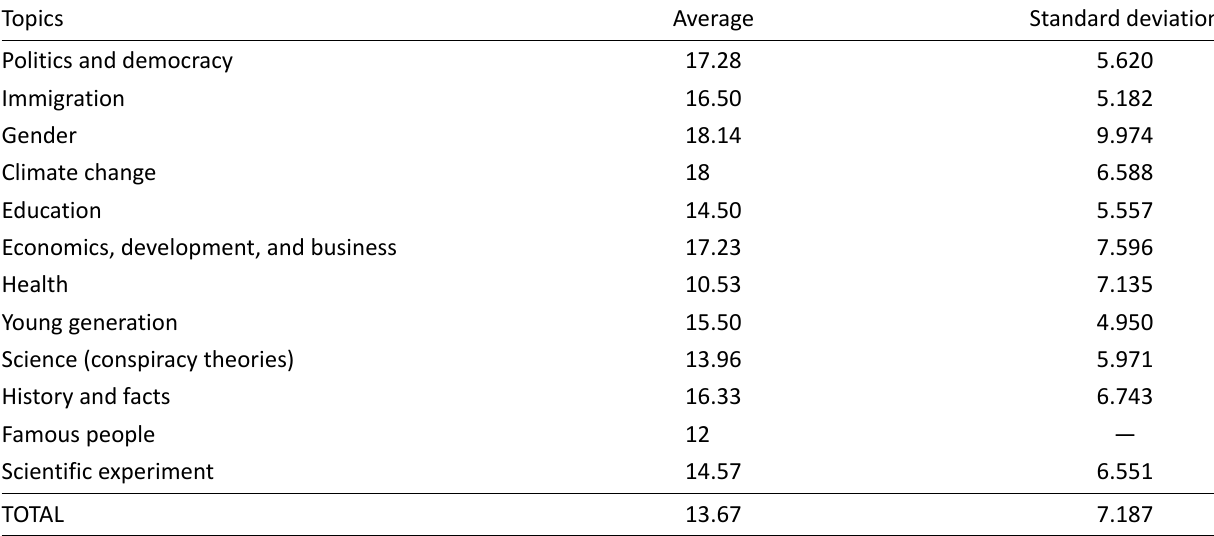
Table 3. Average number of pages per article